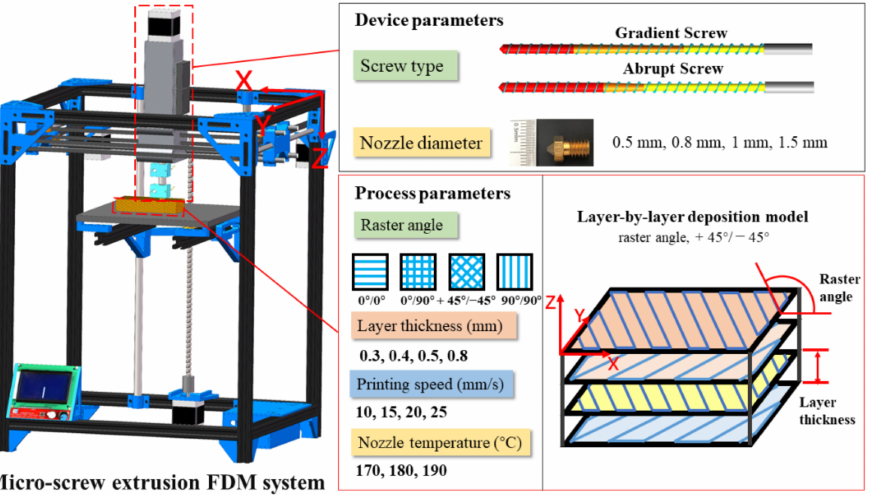
Figure 2. Micro-screw extrusion FDM system and forming parameters.